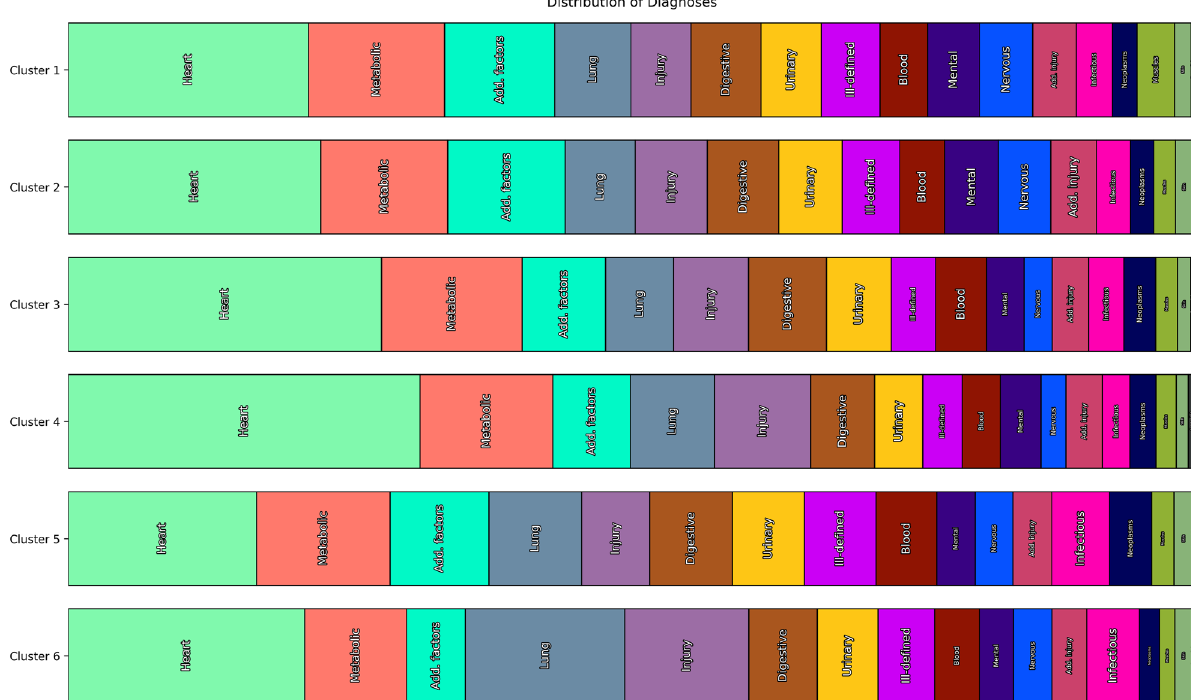
( 39.95 ), occur significantly less in this cluster. Due to the very low mortality, it can be assumed that the patients in this cluster develop serious complications only to a minimal extent. Although similar in biometric features compared to previous clusters, the patients in Cluster 5, the smallest cluster with 3119 admissions, exhibit a relevantly increased mortality ( 34.1% ). There are prevalent diagnoses associated with sepsis, a life-threatening condition that arises when the body’s response to infection damages its tissues and organs. In the enrichment analysis, there are almost exclusively diagnoses representing the sepsis itself ( 038.9 , 038.4 ) or its symptoms, like systemic inflammatory response syndrome or fever ( 995.9 , 780.6 ), their triggering infectious conditions, like pneumonia ( 486 ), and finally its complications, like shock, acidosis, acute kidney failure or thrombocytopenia ( 785.5 , 276.2 , 584.9 , 287.5 ). Also highly enriched is iatrogenic immuno- suppression through immunosuppressive or antineoplastic drugs ( E933.1 ), which increases the risk for sepsis. Moving beyond the enriched diagnoses listed in Table 2, there is a multitude of additional sepsis triggers, like intestinal infection ( 008.4 ), aspirational pneumonitis ( 507.0 ), urinary tract infection ( 599.0 ) or infection of an internal prosthetic device, implant, or graft ( 996.6 ). The cornerstone of sepsis therapy consists of sufficient intra- venous fluid replacement and therapy with broad-spectrum antibiotics. If a focus of infection is evident, it needs to be controlled, usually by draining the infectious fluids. Such a measure of focus control is the percutaneous abdominal drainage ( 54.91 ), which is enriched in this cluster. Apart from that, only a few interventions occur more frequently in this cluster than in its complement. Among them, there are central venous catheterizations for fluid replacement ( 38.97 , 38.93 ), arterial catheterizations ( 38.91 ), and measures to treat organ dysfunctions, like mechanical ventilation ( 86.04 , 96.71 , 96.72 ), hemodialysis ( 38.95 , 39.95 ) and administration of vasopressive agents ( 00.17 ). Finally, Cluster 6 represents the cluster with the highest mortality of 37.0% , which is almost three times as high as within the total population. Moreover, it is the cluster with by far the most extended treatment duration in the ICU, namely 9 days in the median. The patients exhibit a clear gap in the length of stay between survivors and deceased patients (12 days vs. 9 days), indicating a prolonged recovery time if a life-threatening condition was survived. In the list of the most prevalent diagnosis as well as in the list of enriched diagnoses, lung-related problems, such as pneumonia/pneumonitis ( 507.0 , 482.4 , 486 ) or pulmonary insufficiency ( 518.5 ), are dominant. The most prevalent and most enriched diagnosis “ 518.8 - Other diseases of the lung” ( 47.3% , + 189.0% ) contains different forms of acute and chronic respiratory failures, but also the acute respiratory distress syndrome (ARDS),